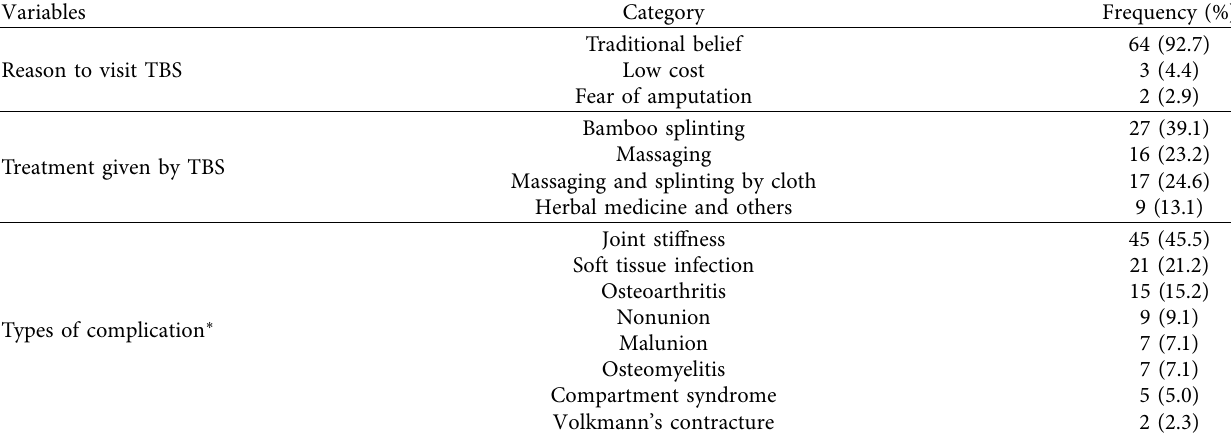
Table 3: TBS-related information and complications among patients with fracture in DMCSH, 2021.